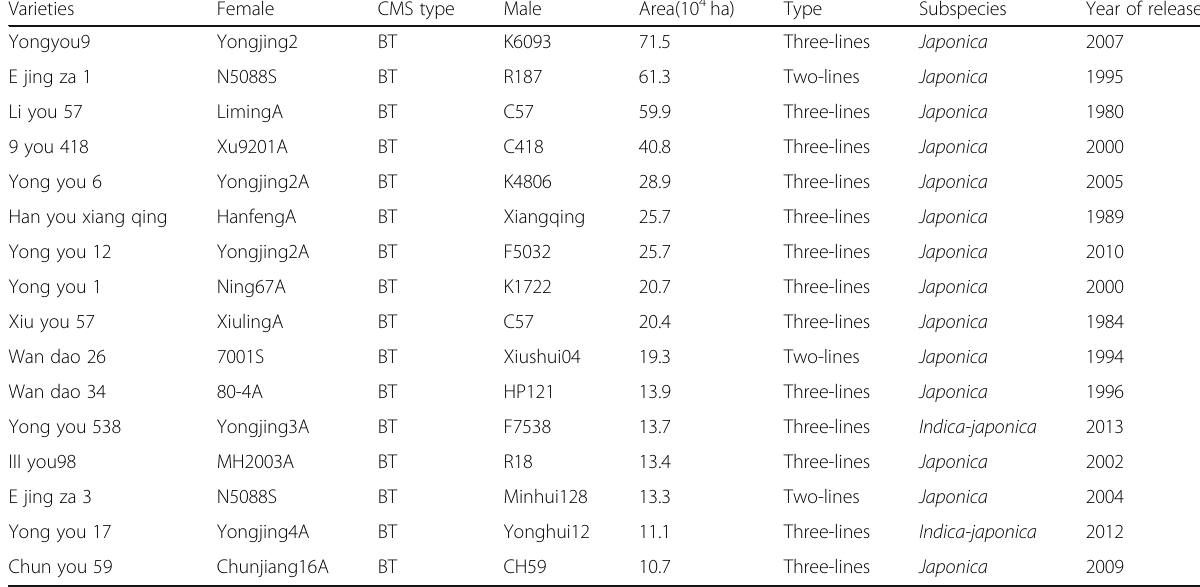
Table 4 List of varieties with an area of more than 100,000 ha